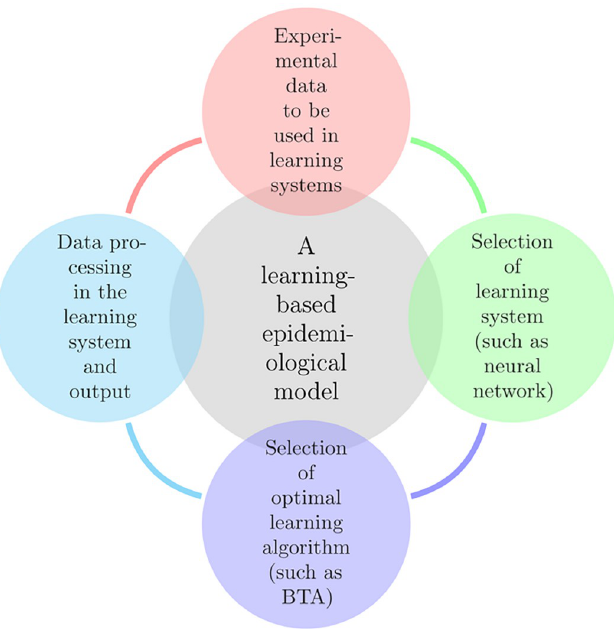
Fig 1. An epidemiological learning